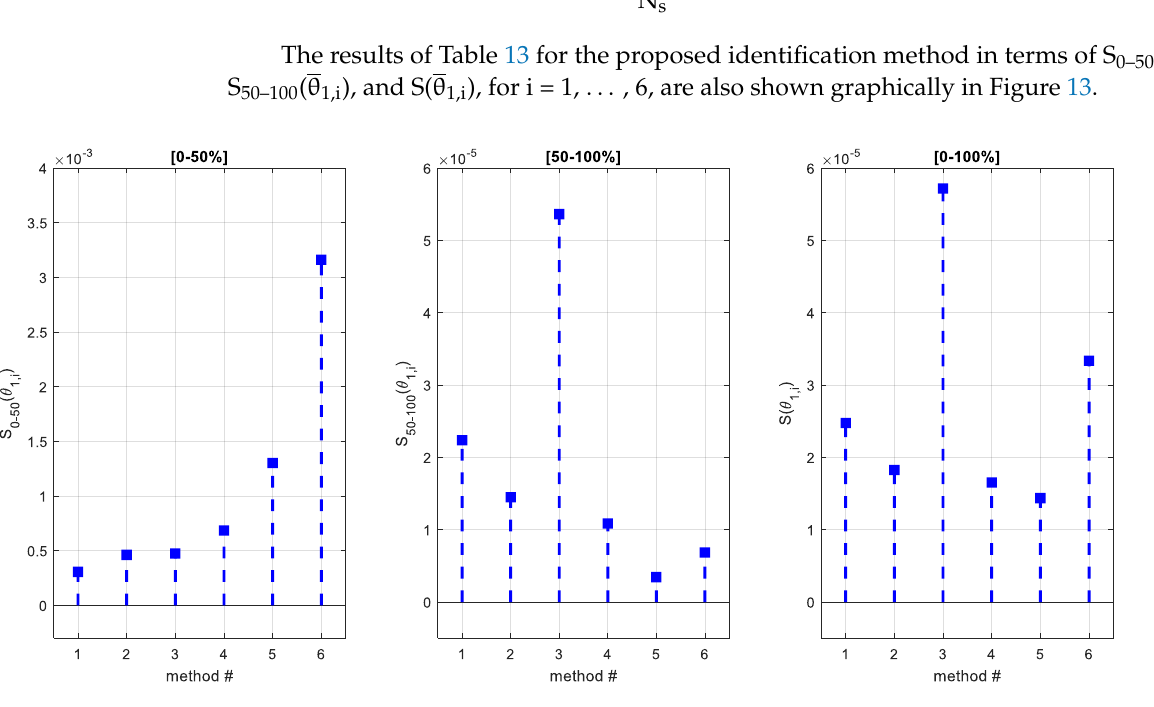
Figure 13. Graphical representation of the data given in Table 13 for process P 1 . From left to right the performance indexes S 0 – 50 ( θ ̅ 1,i ), S 50 – 100 ( θ ̅ 1,i ), and S( θ ̅ 1,i ), i = 1, …, 6, are shown, respectively, for each of the considered